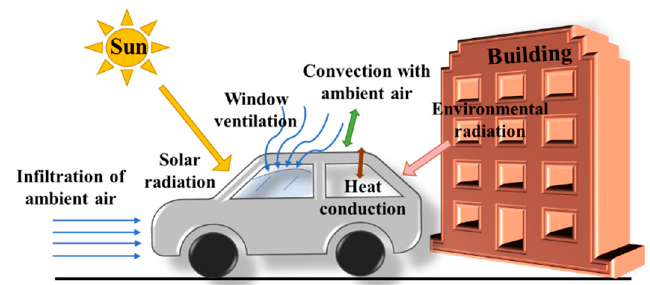
Figure 1. Factors affecting the vehicle cabin thermal environment.